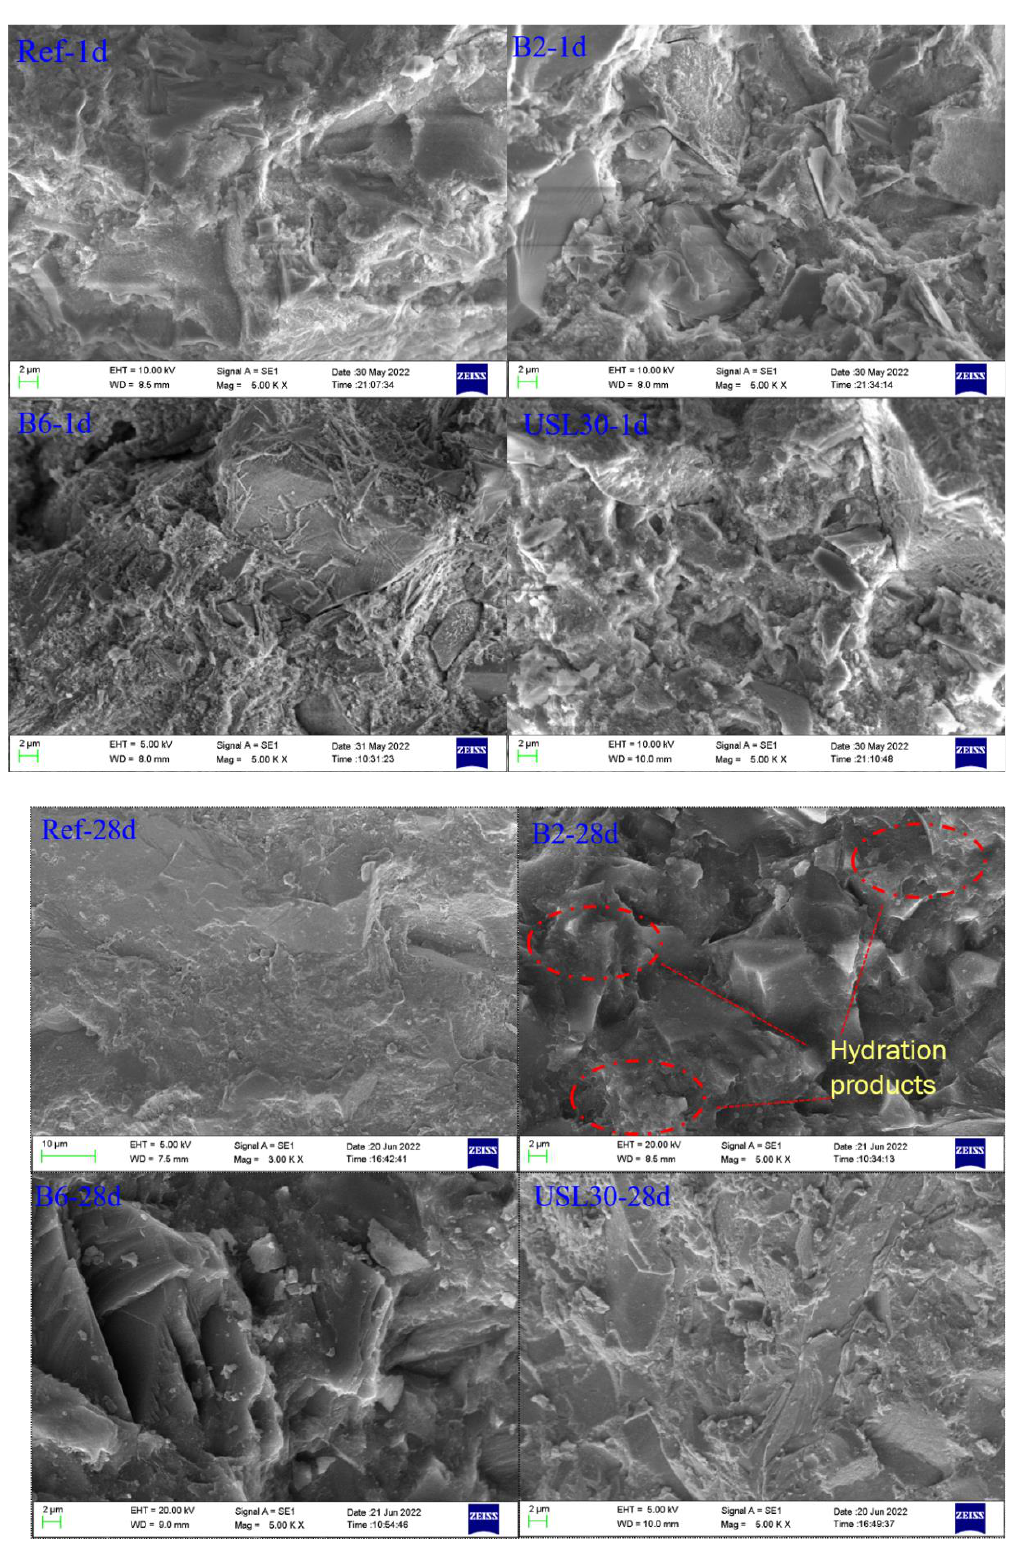
Figure 9. SEM pictures of the Ref, B2, B6, and USL30 pastes at 1 d and 28